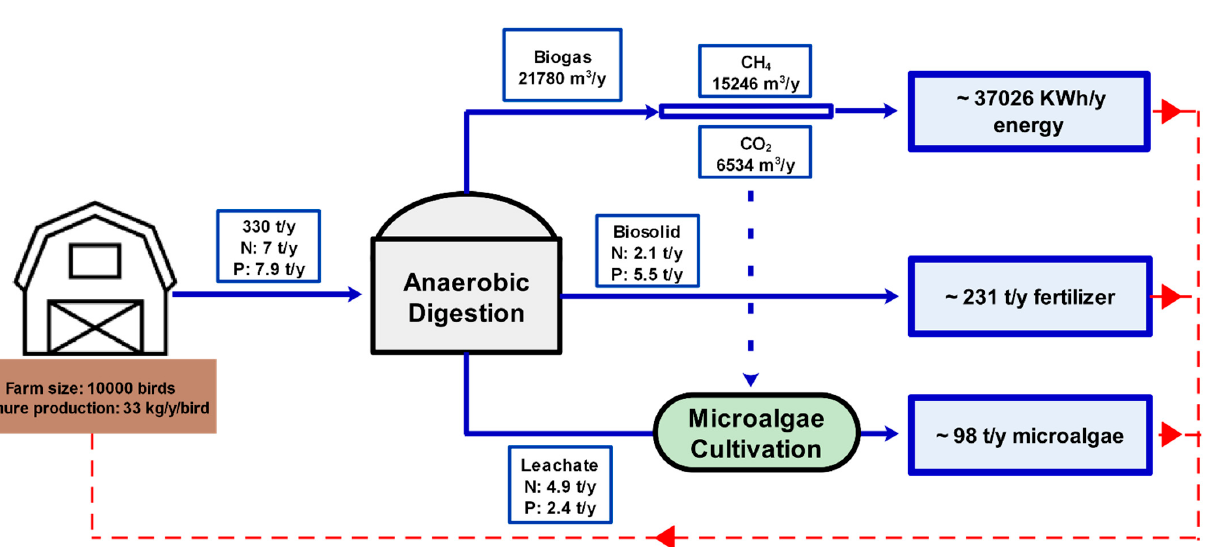
Table 4. Average nutrient content per ton of CM.